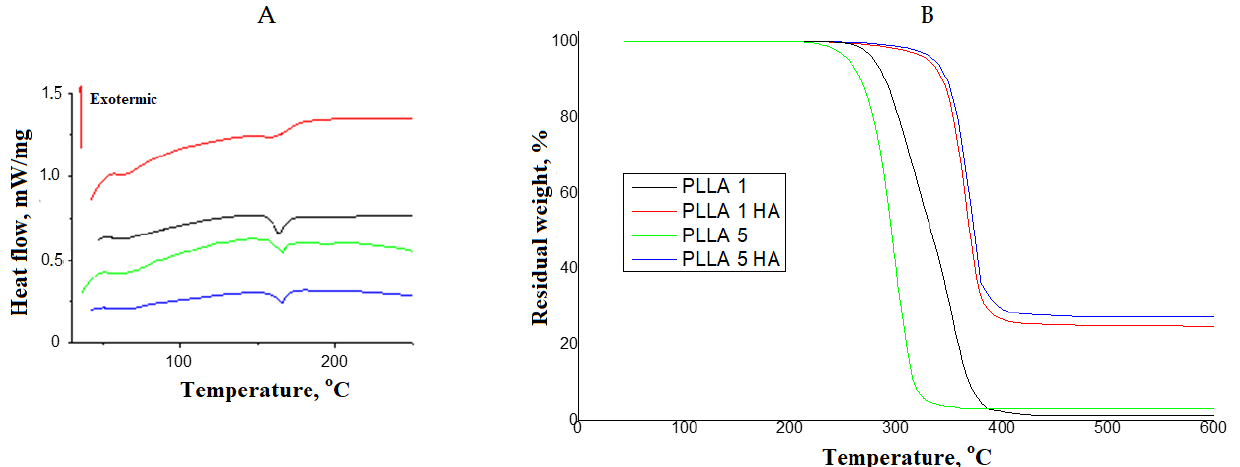
Figure 4. Representative thermal analysis data for composite samples: DSC curves ( A ) and TGA curves ( B ). Table 3. Thermal properties of PLLA